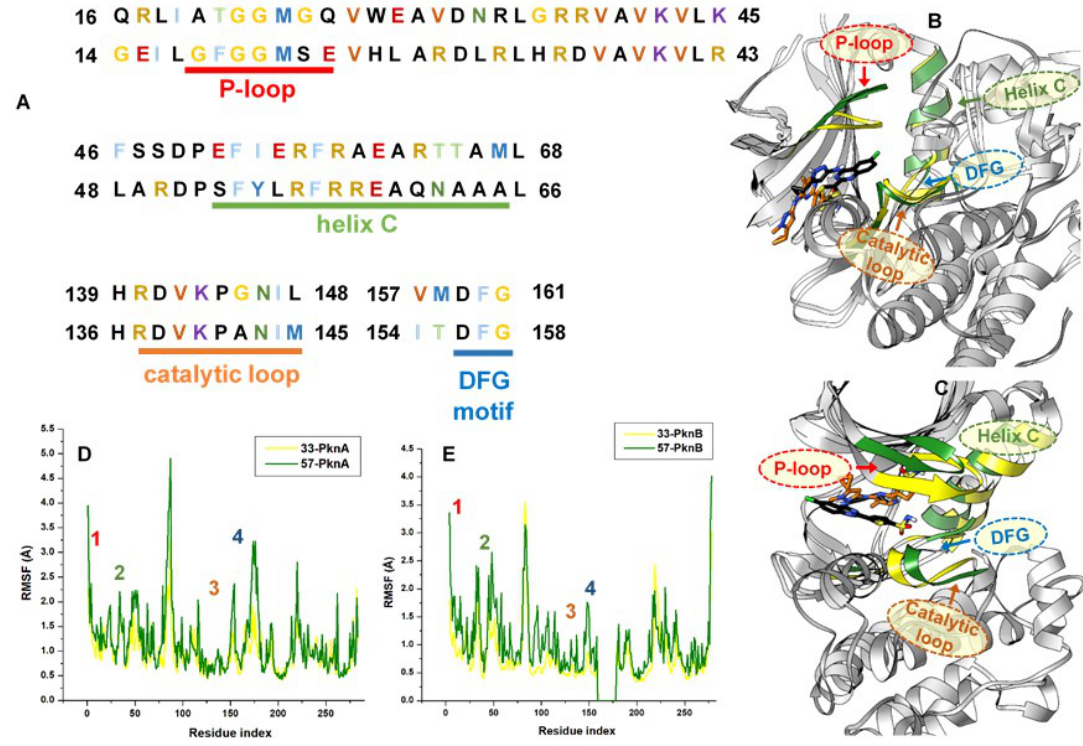
Figure 4. RMSF plots showing per-residual fluctuations across key components of PknA and PknB structures. ( A ) Sequence alignment of the NBP region of both proteins showing variations in constituent residues. Highlighted are the various residue sequences that encompass the P-loop (red), helix C (green), catalytic loop (brown) and DFG motif (blue). These regions are color-indicated on the RMSF plot in ( D ) (1 = P-loop, 2 = helix C, 3 = catalytic loop, 4 = DFG motif). 3D structural alignment of 33 - (black) and 57 - (orange) bound PknA and PknB are shown respectively in ( B ) and ( C ).